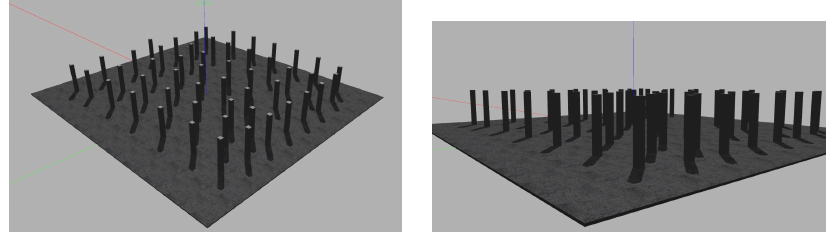
Figure 6. Cluttered environment in the simulation.